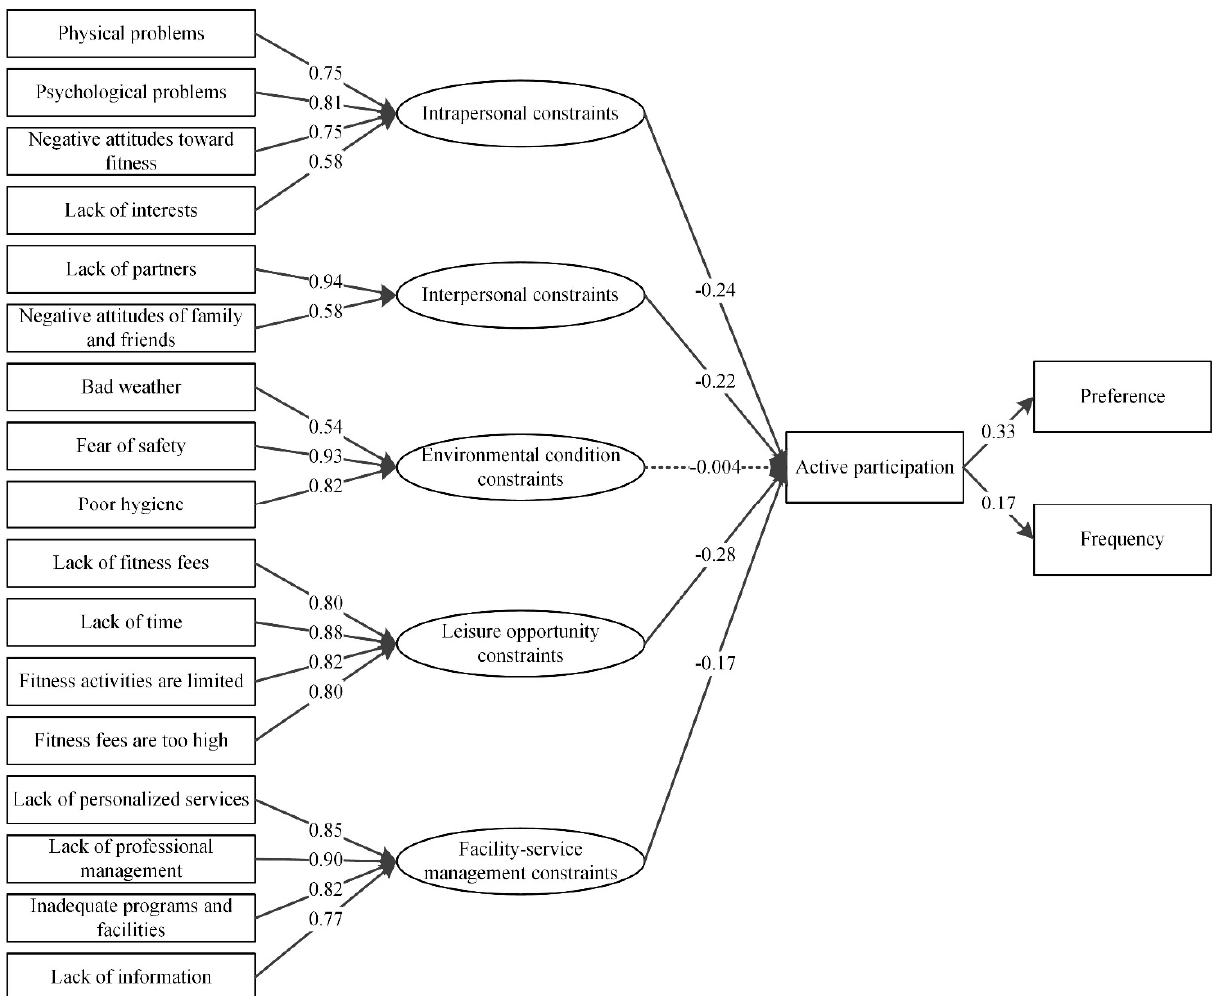
Figure 2. Graphical summary of the structural model results. Dotted line indicates the non-signifi- cant results.